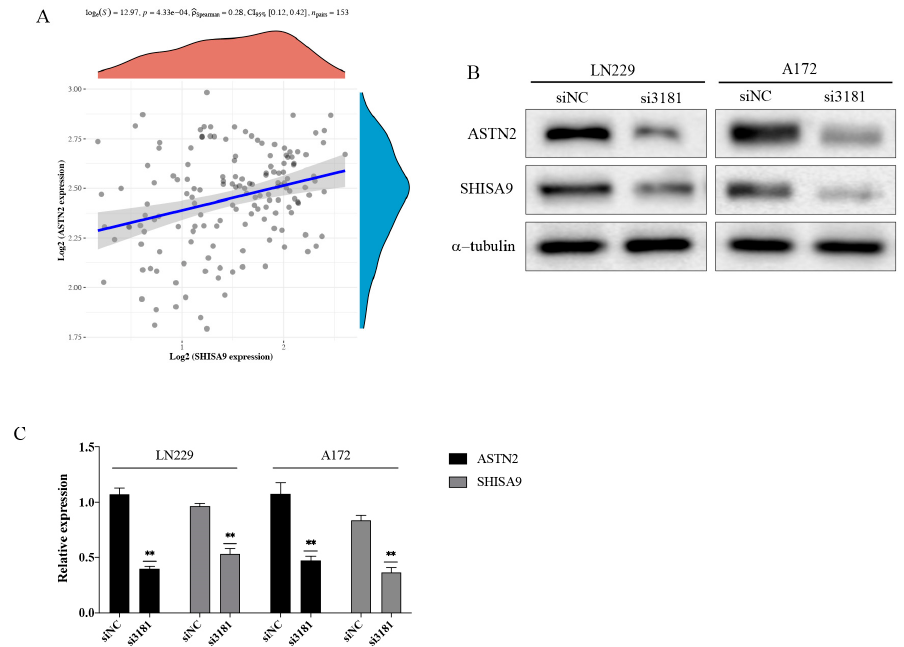
Figure 12. ASTN2 and SHISA9 have a significant positive correlation. ( A ) Bioinformatics analysis results show a signif- icant positive correlation between ASTN2 and SHISA9. ( B ) and ( C ) Western blot shows that the expression of SHISA9 decreased after down-regulation of ASTN2. ** p < 0.01.